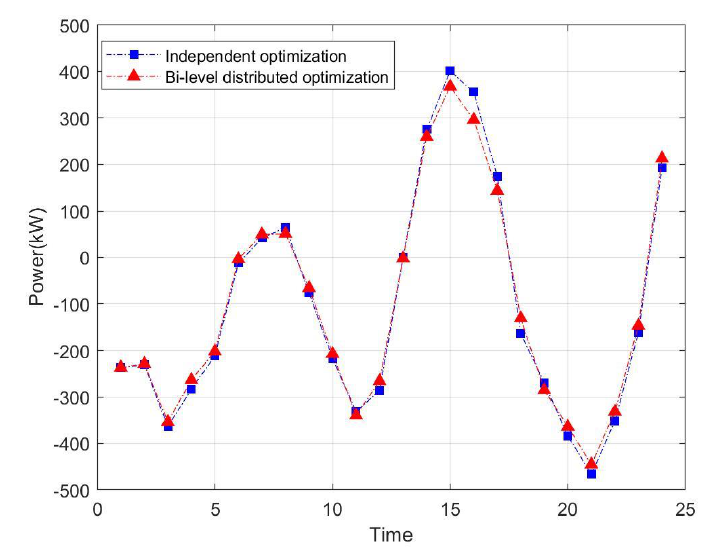
Figure 8. Result of two optimization methods of VMG1.